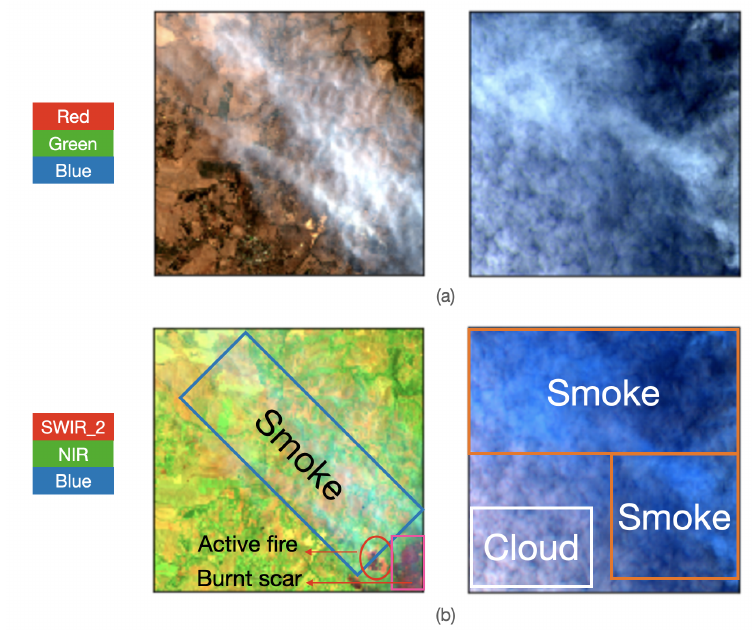
Figure 2. Two fire smoke scenes are visualised in different bands. ( a ) RGB. ( b ) SWIR_2, NIR, and